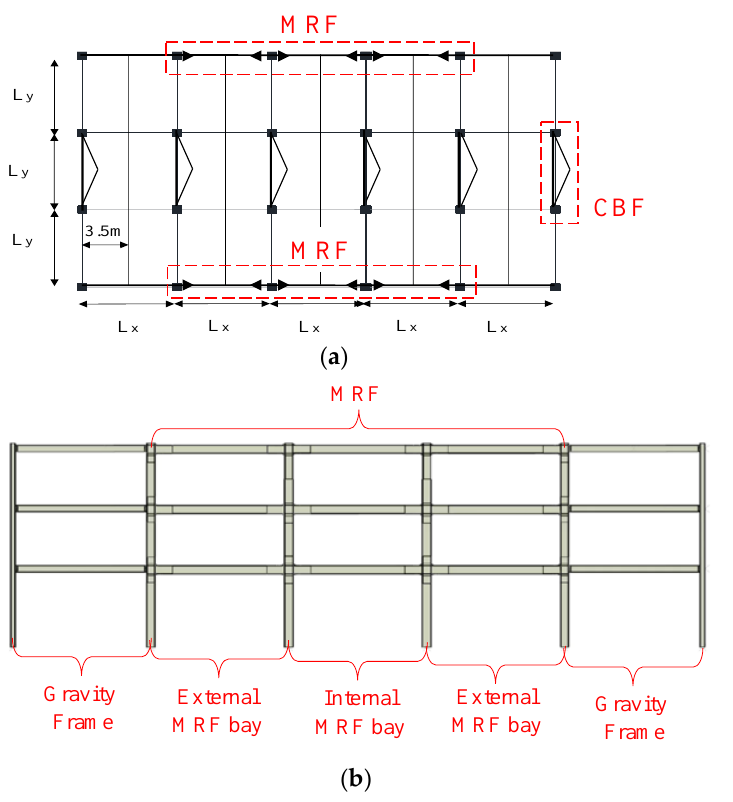
Figure 1. Moment-resisting frame (MRF) and concentrically braced frame (CBF) layout and main geometrical features of the building archetype ( a ) and Perimetral MRF ( b ) view. Table 1. Cross section of the investigated moment-resisting